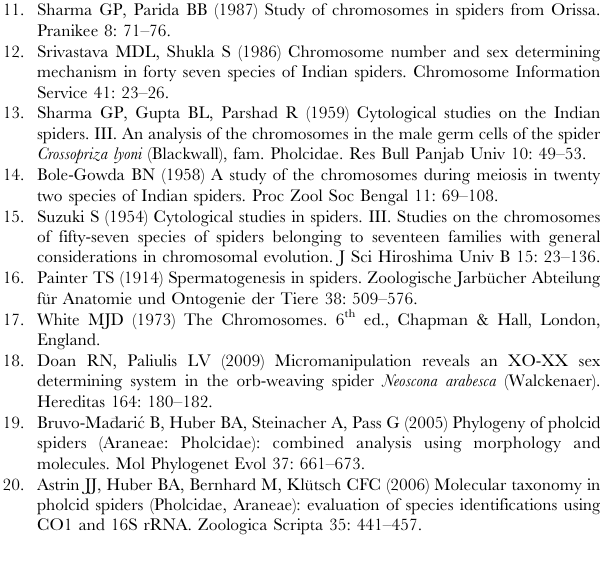
Figure 1B, with 28 chromosomes. Arrow points to X